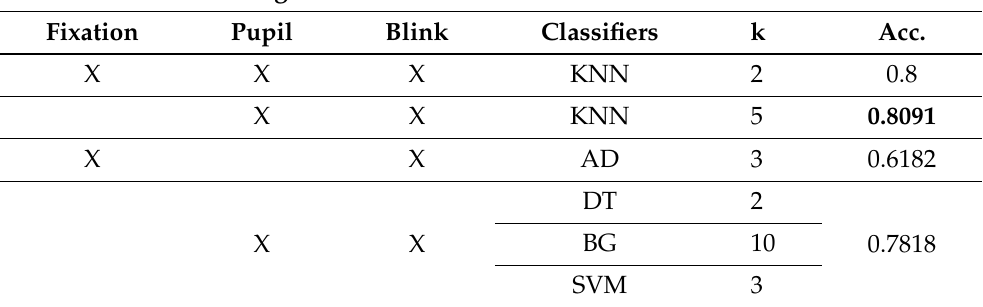
Table 4. The results of the age classification are obtained from combination of the best scores of the three biometric traits. k is the value of the implemented k-fold cross-validation strategy relating to the best accuracy achieved. The numbers in bold are the best results. X indicates the features selected for